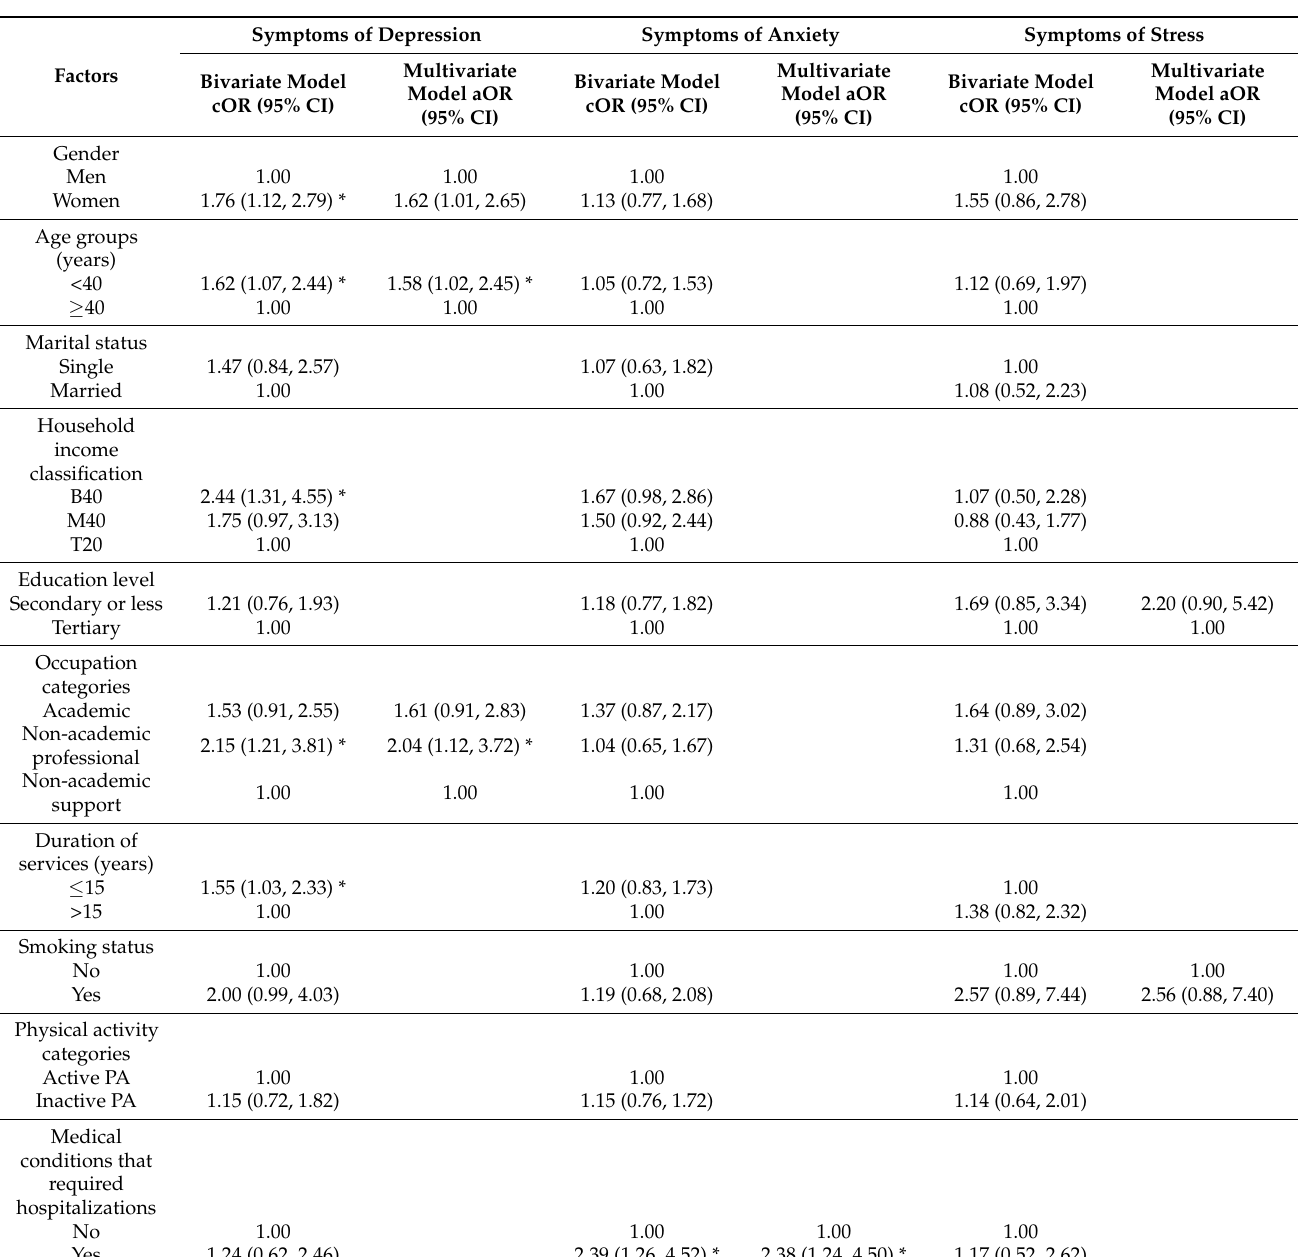
Table 3. Factors associated with perceived symptoms of depression, anxiety, and stress among university staff.